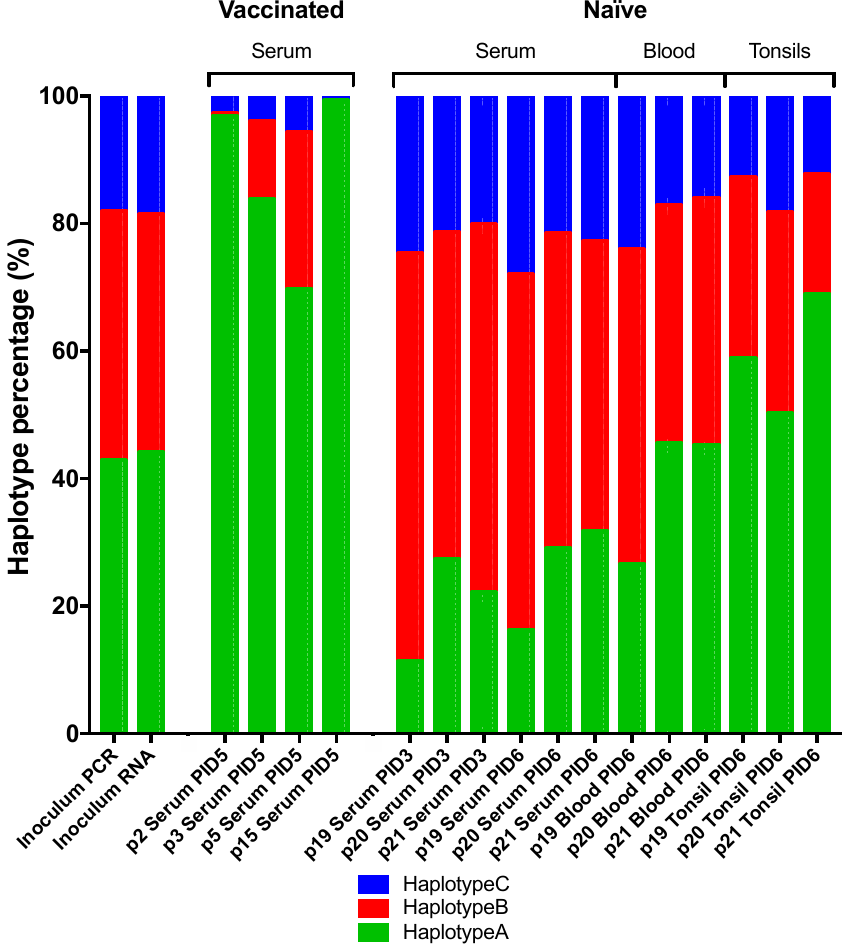
Figure 6. Haplotype distribution in virus populations of all samples across the complete ORF. Stacked bar diagram showing the percentage distribution of haplotype A (C2661T (aa S763L), G3205A, C4612G, T4750C, T9940C, and A10669G), B (C2134T, T4150C, G5101A, and G11374C), and C (Koslov consensus), respectively. Haplotype distribution was calculated for each sample as the average of all SNPs constituting the haplotype A or B and summed. The remaining percentage, subtracted from 100%, was inferred to constitute haplotype